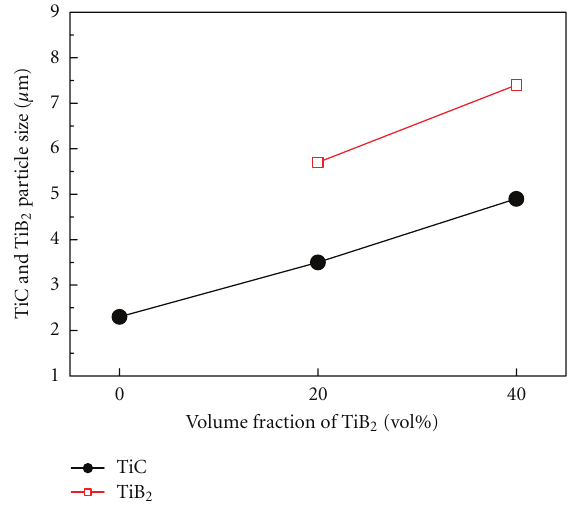
Figure 7: E ff ect of TiB 2 volume fraction on relative density and Vickers hardness of samples with 20vol%